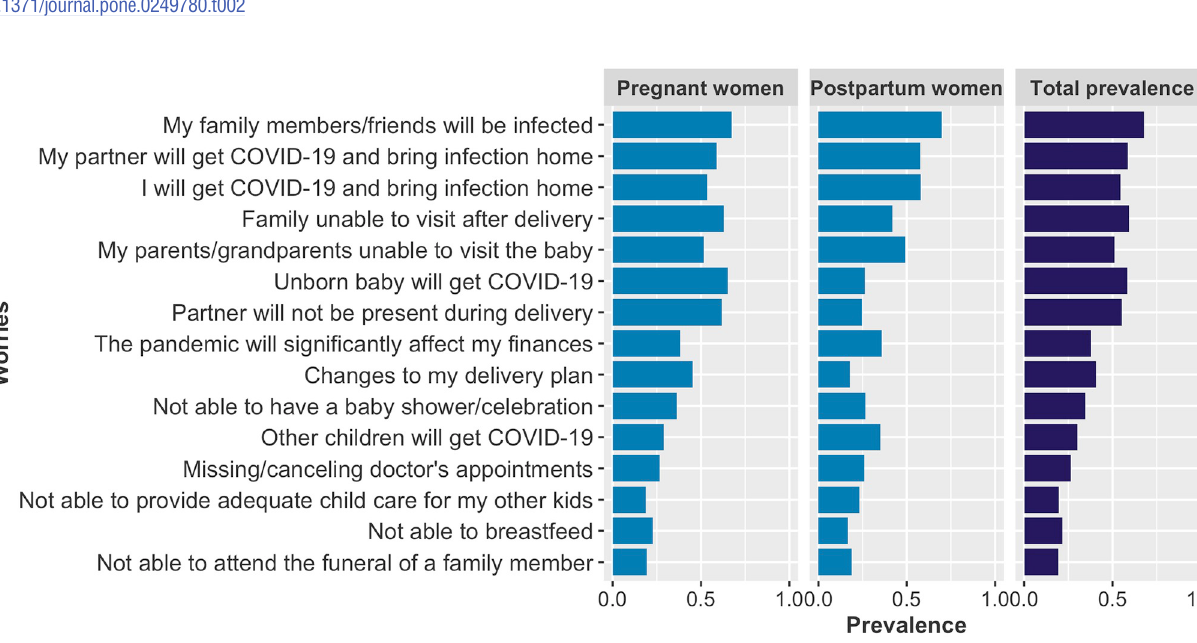
Fig 3. Prevalence of COVID-19 related worries for pregnant and postpartum